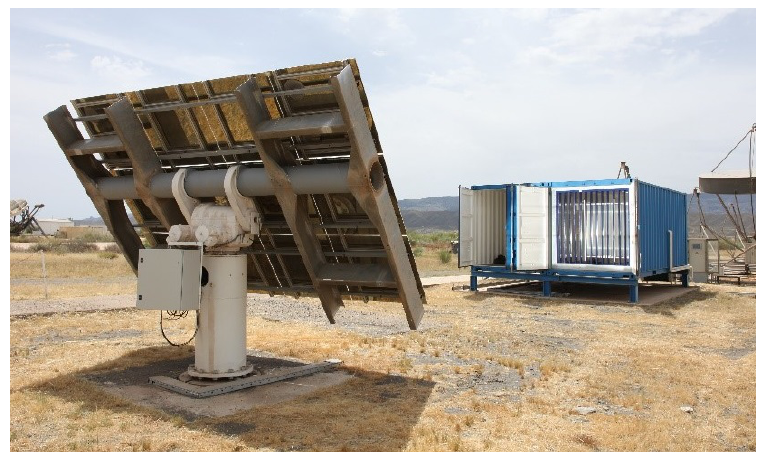
Figure 2. New PSA Fresnel lens solar furnace.